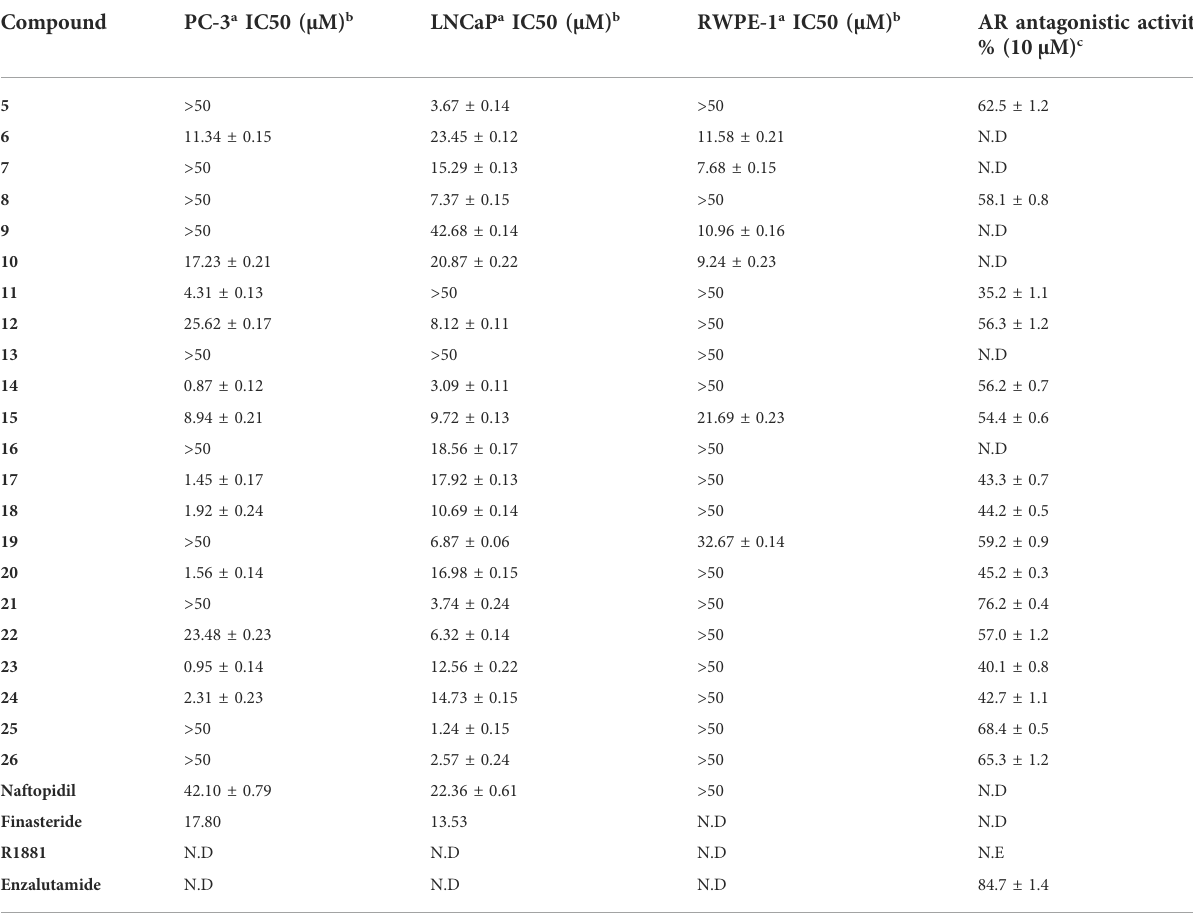
TABLE 1 Antiproliferative and AR antagonist activity of derivatives 5 –